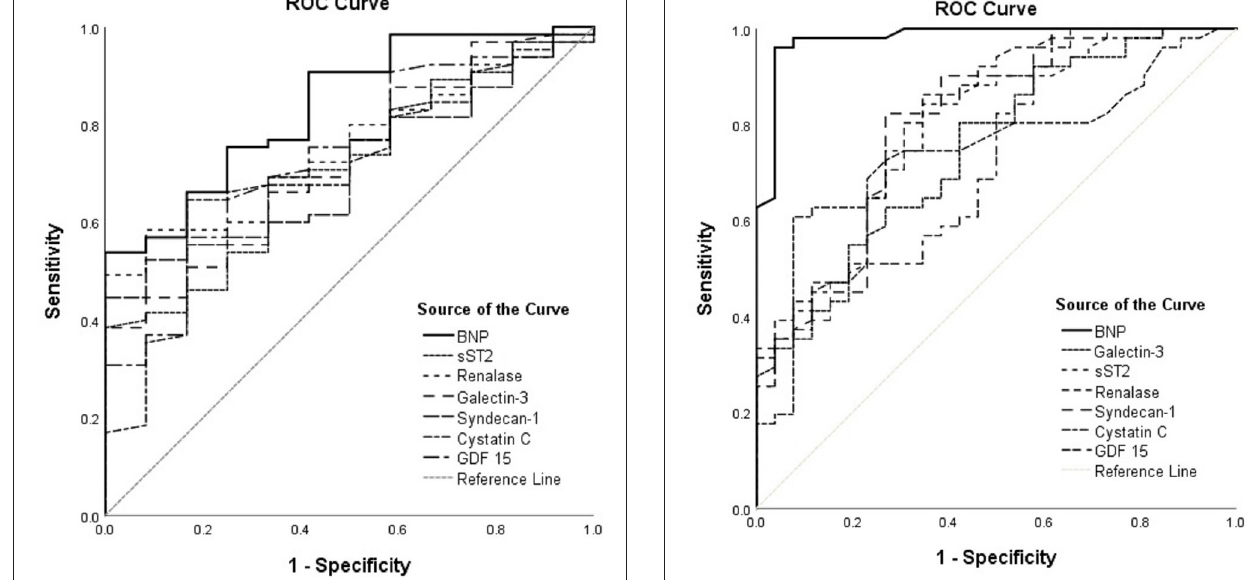
FIGURE 1 | ROC curves of renalase and evaluated biomarkers for the prediction of ischemia in the total heart failure group. The curves should be interpreted with regard to Table 4 . AUCs: BNP (0.837), sST2 (0.712), renalase (0.753), galectin-3 (0.726), syndecan-1 (0.709), cystatin C (0.704), GDF-15 (0.735). ROC, receiver operating characteristic; AUC, area under the curve; BNP, brain natriuretic peptide; sST2, soluble source of tumorigenicity 2; GDF-15, growth differentiation factor 15.